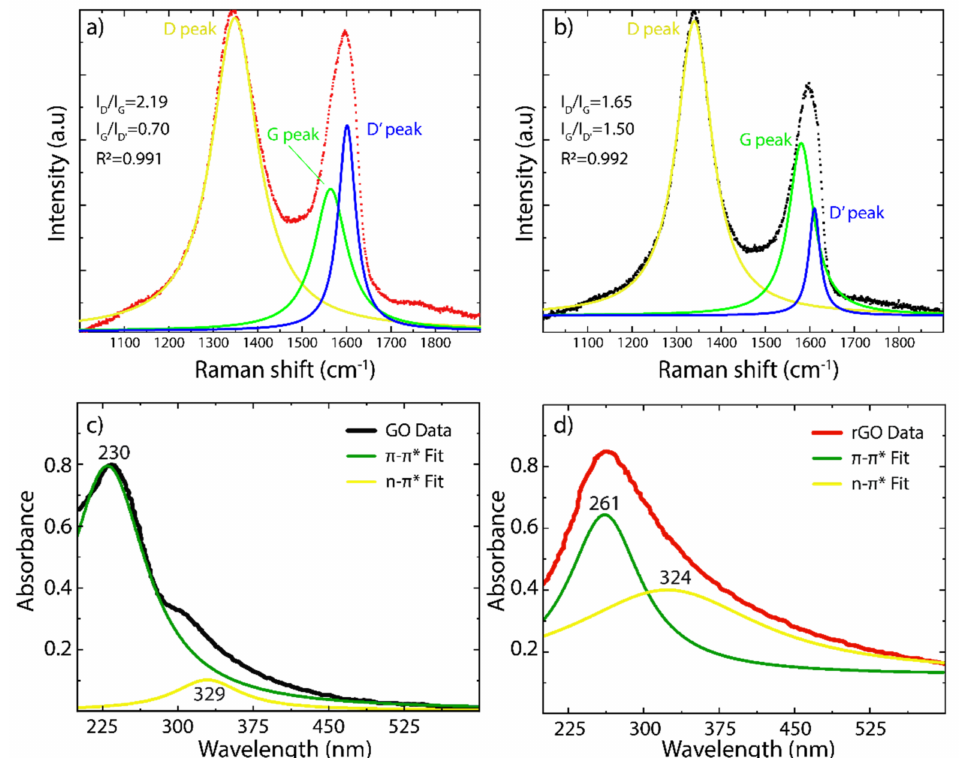
Figure 3. Raman spectra of ( a ) GO and ( b ) rGO from 1000 to 2000 cm − 1 . The intensity was normalized by the most intense peak. The Raman spectrum was fitted using Lorentzian functions. UV–Vis spectra of ( c ) GO and ( d ) rGO and the absorbance spectra were fitted by Lorentzian